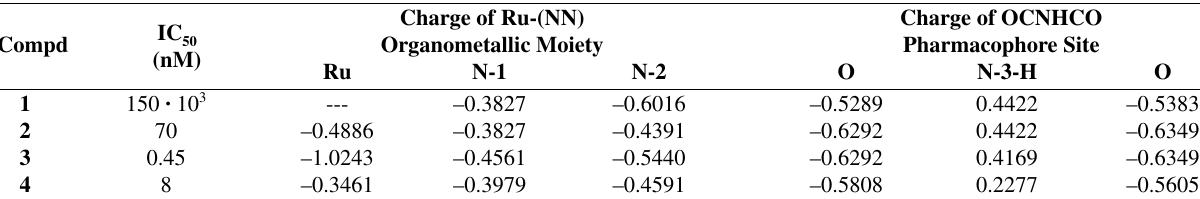
Table 4. Electronic impact on antitumor activity of (OCNHCO) pharmacophore site by coordination of drug ( 1 ) to electron rich organometallic mo- iety (2 –